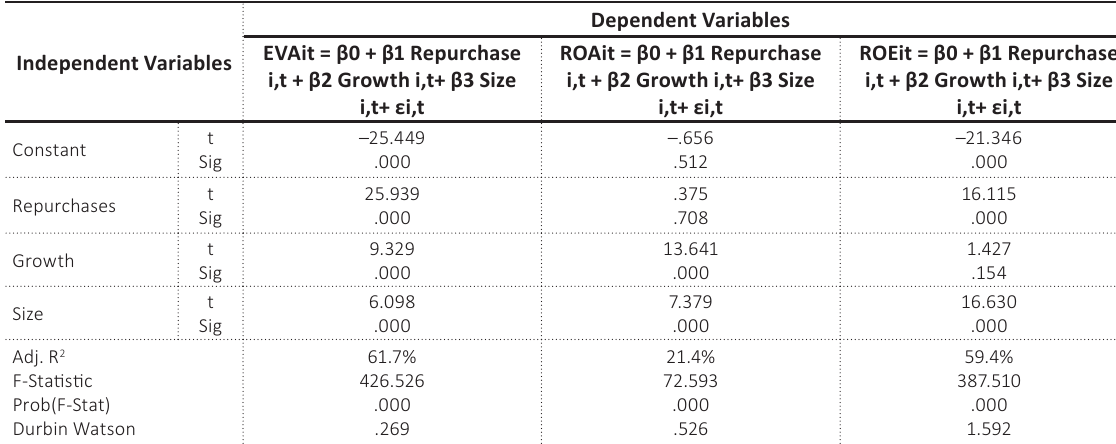
Table 5. Financial performance predictability using share